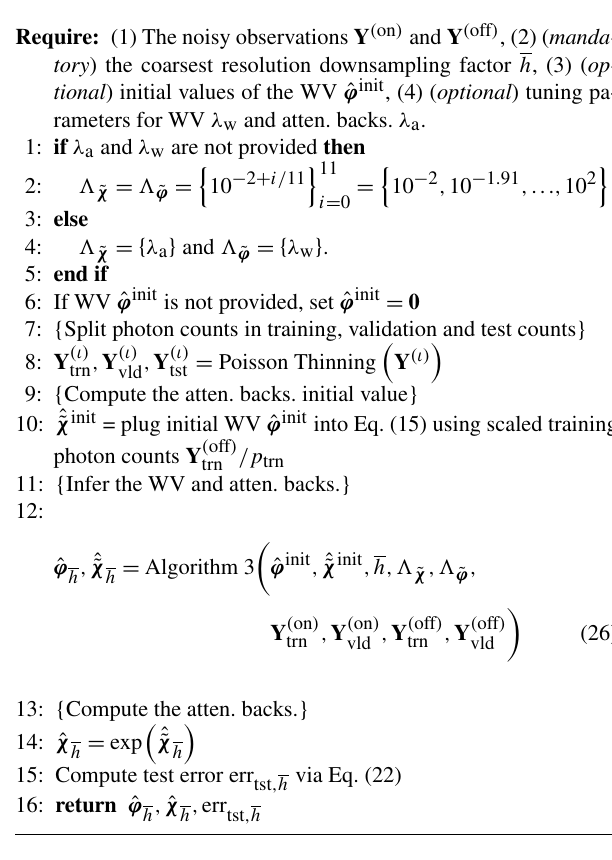
Algorithm 2 The PTV-MPD